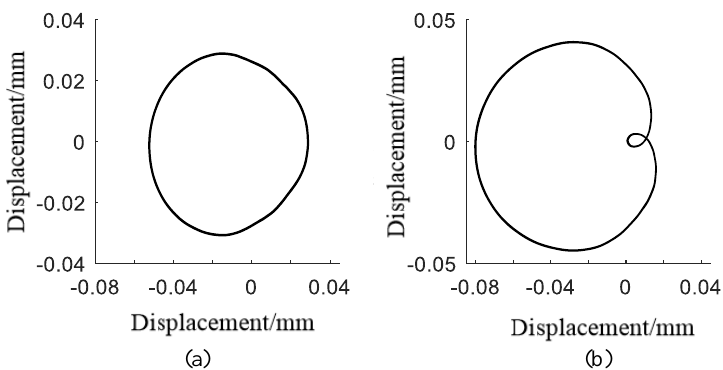
Figure 13. Vibration response axis locus of generator rotor: ( a ) misalignment 1.5 mm, short-circuit 5%; ( b ) misalignment 5 mm, short-circuit 5%.